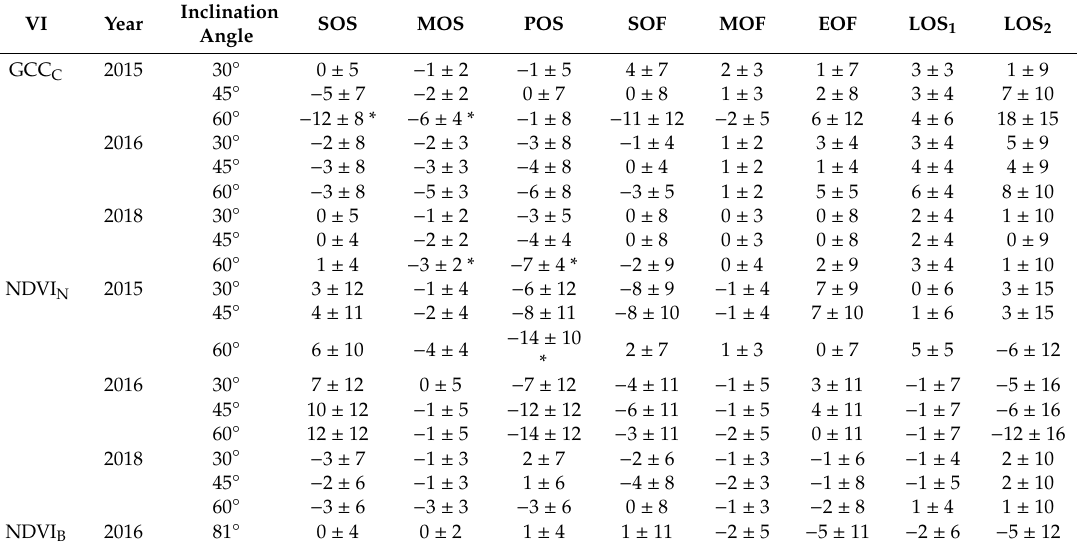
Table 2. Comparisons of the phenophases (number of days, mean ± 95% confidence interval) estimated from 30 ◦ , 45 ◦ , and 60 ◦ of inclination-angles with reference to 15 ◦ for the north direction in the three measuring years. The comparisons for the radiometer were conducted between 81 ◦ and 90 ◦